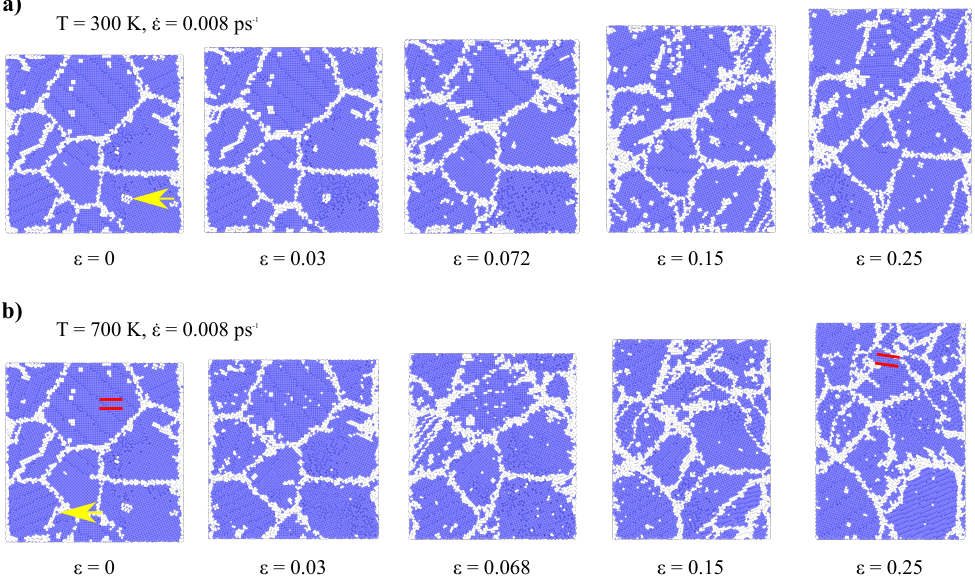
Figure 3. Snapshots of the specimen observe during tensile loading at a constant strain rate and different